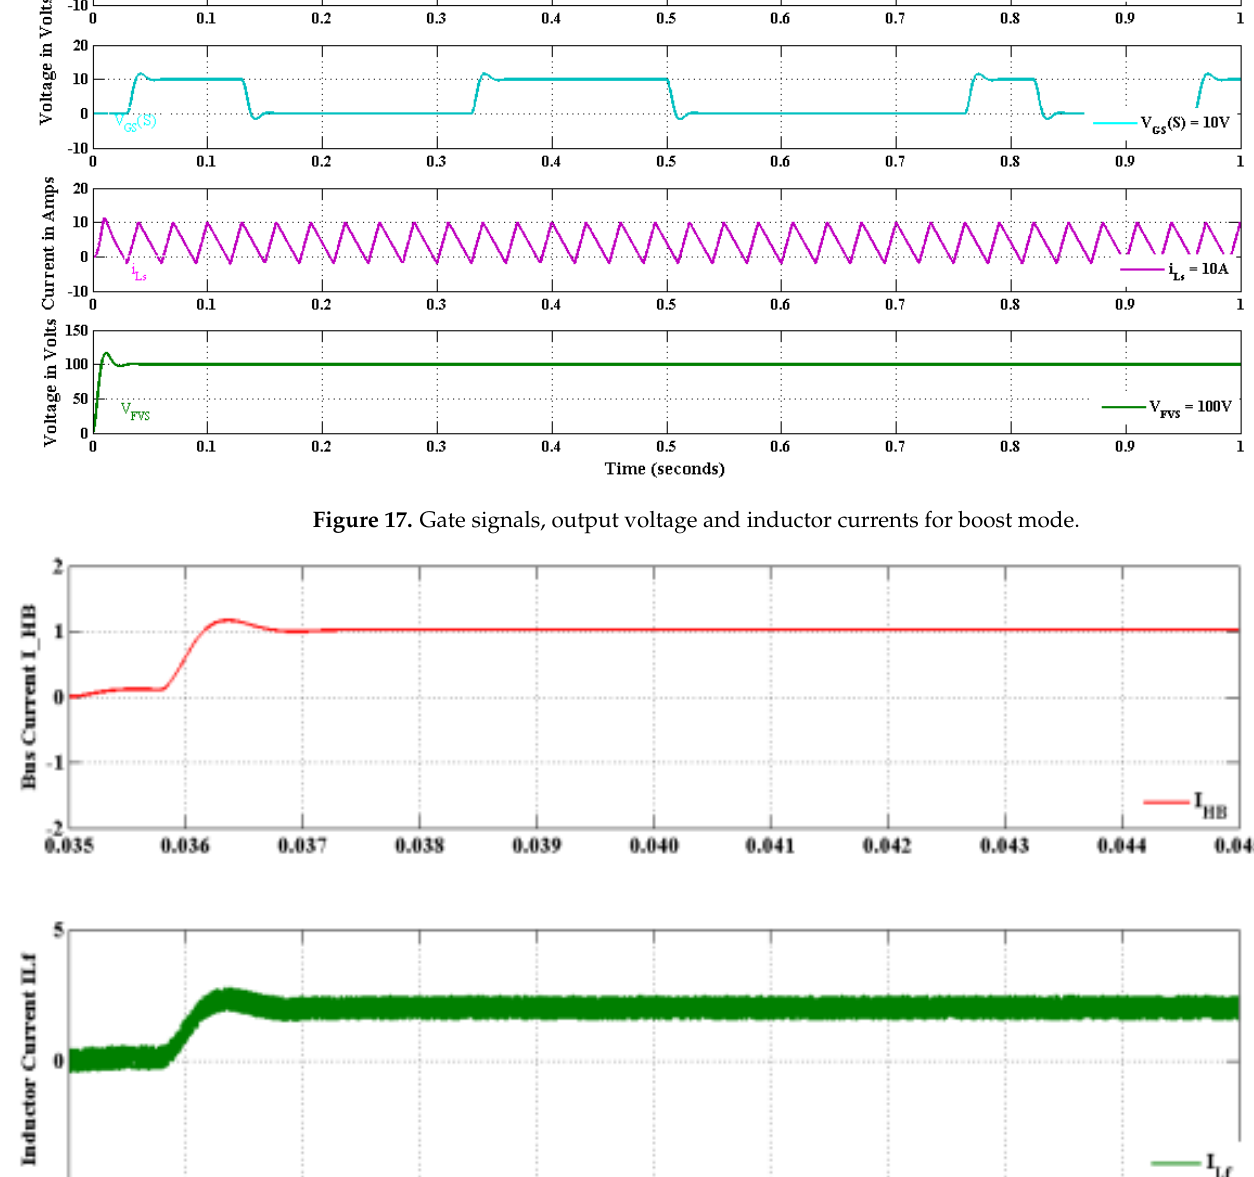
Figure 18. Regulated current step variations in inductor currents at dual low voltage sources.